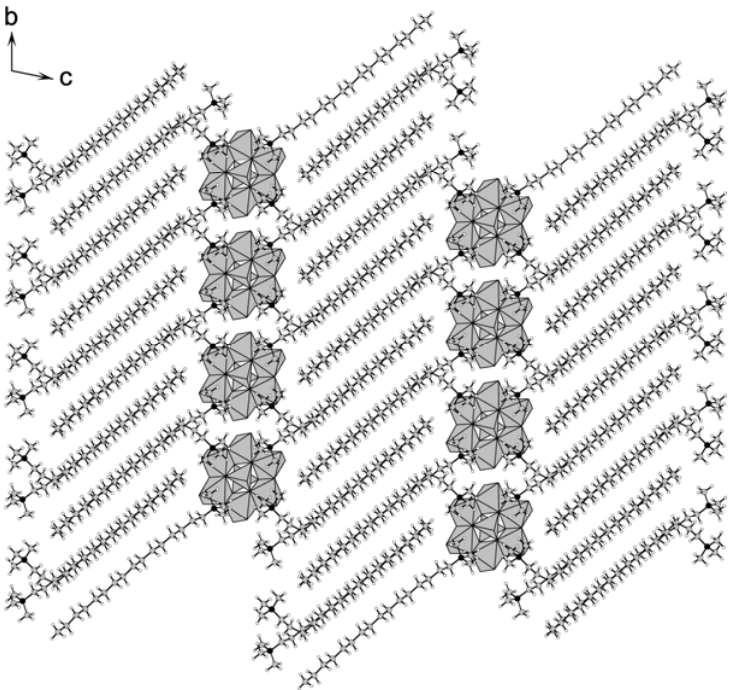
anions in grey polyhedra). 8